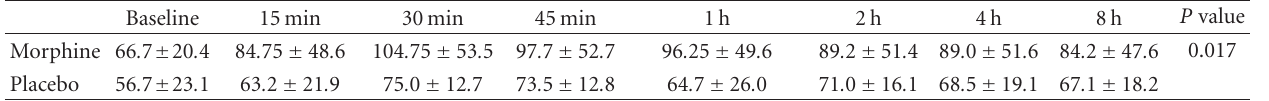
Table 3: Pick flow meter over the time in total 5 days after inhalation in two